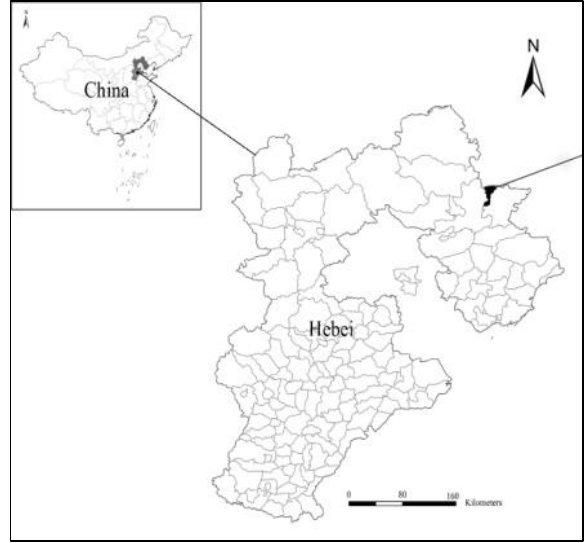
Figure 1. Location of Liaoheyuan Natural Reserve, Hebei Province, China.